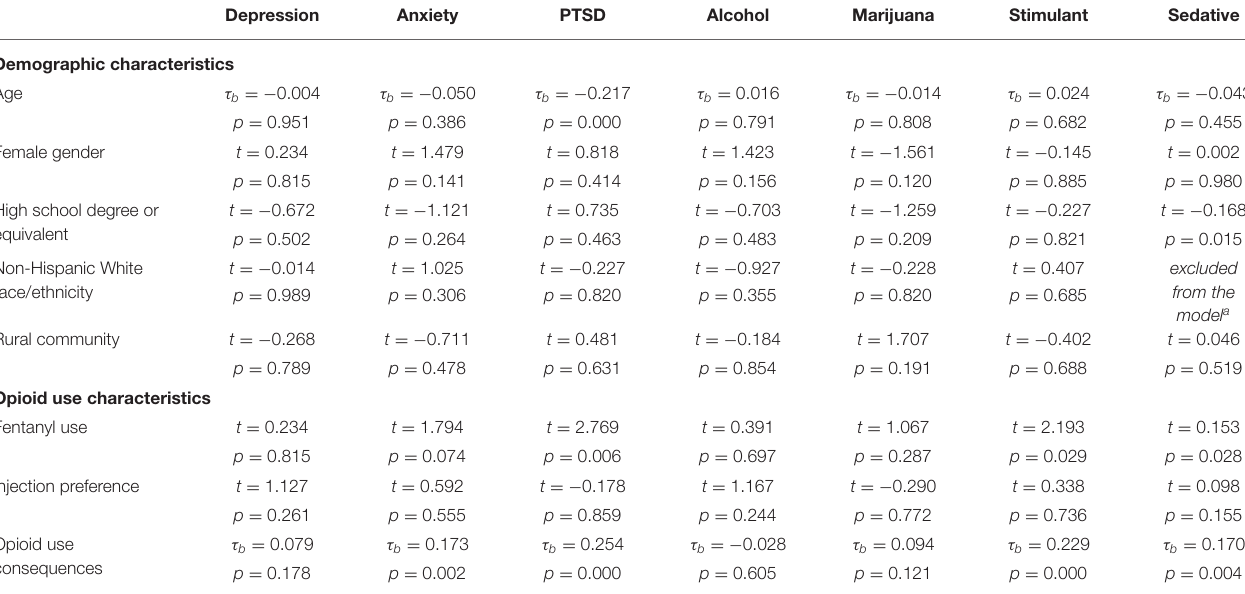
TABLE 2 | Group differences for comorbid disorders by demographic and opioid use characteristics. Depression Anxiety PTSD Alcohol Marijuana Stimulant